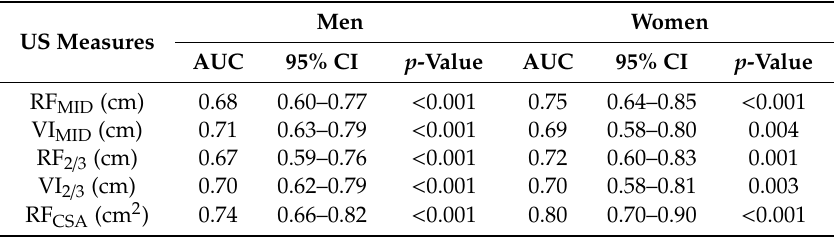
Table 4. ROC analysis for US measures for determination of PEW risk.